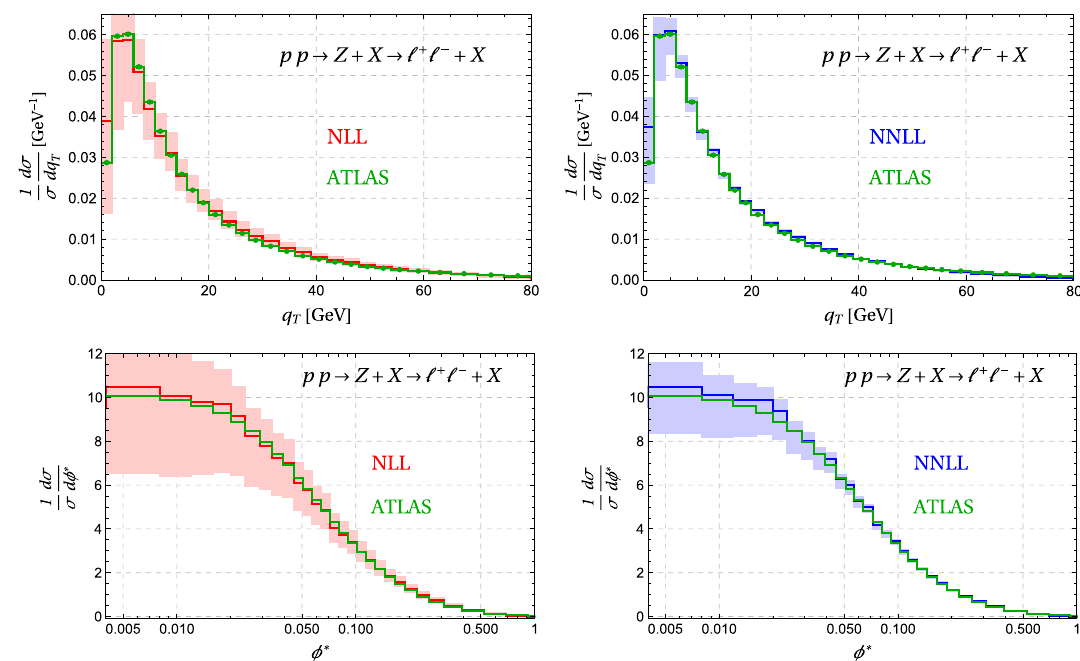
Fig. 8 Comparison of the NLL (red) and NNLL (blue) results for the q T and φ ∗ spectra. The plots show the result without matching. For visual reference, we also include ATLAS measurements (green points) [32]